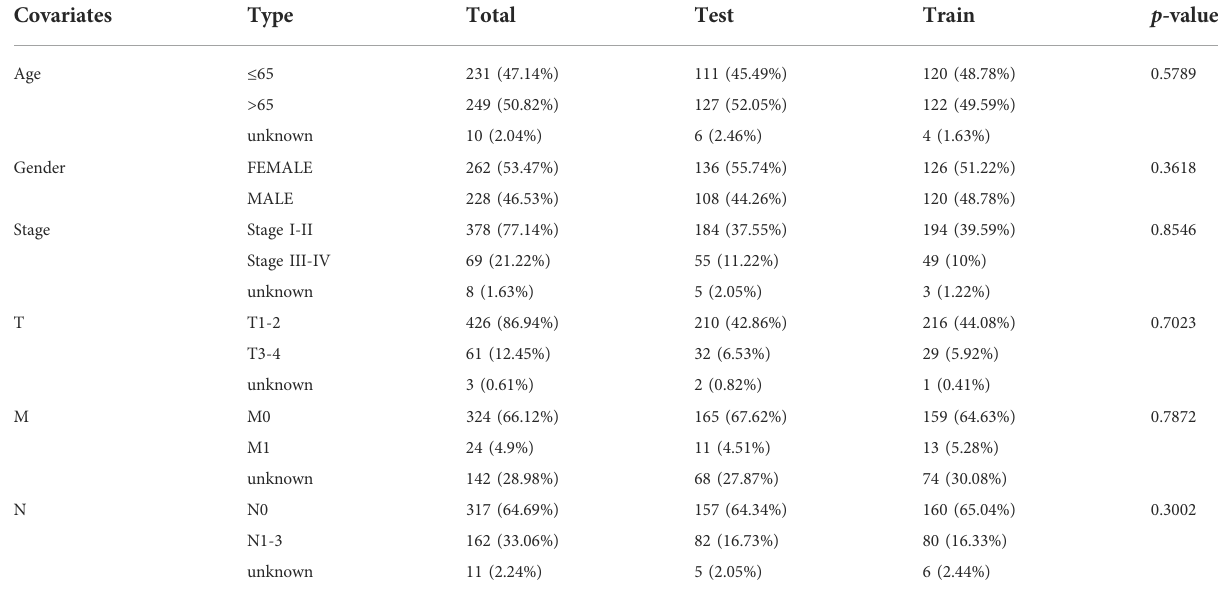
TABLE 1 The clinical characteristics of included